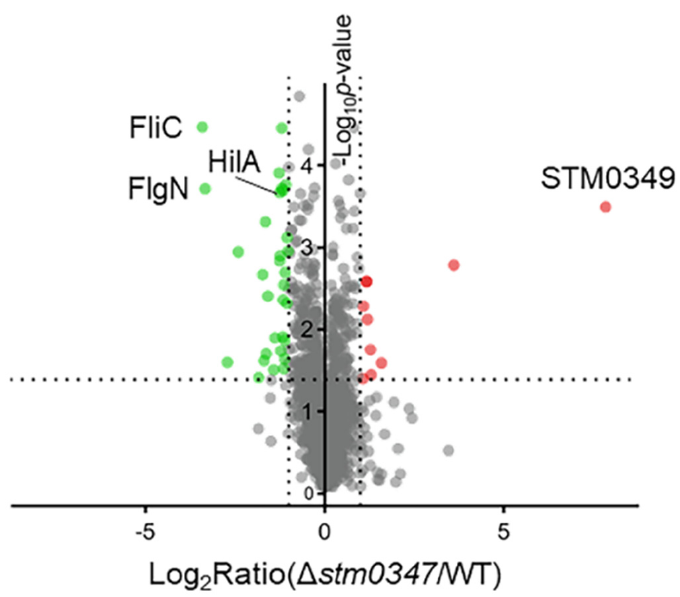
Figure 2. A volcano plot of Salmonella WT and ∆ stm0347 strains detected by LC–MS/MS analysis. The logarithmic values of the abundance ratios of ∆ stm0347 to WT was reported on the x -axis. The negative logarithmic p -values processed with t test was presented on the y -axis. Dotted lines denote two-fold (vertical) and p < 0.05 cutoff (horizontal). Data was collected from three biological repli- cates.